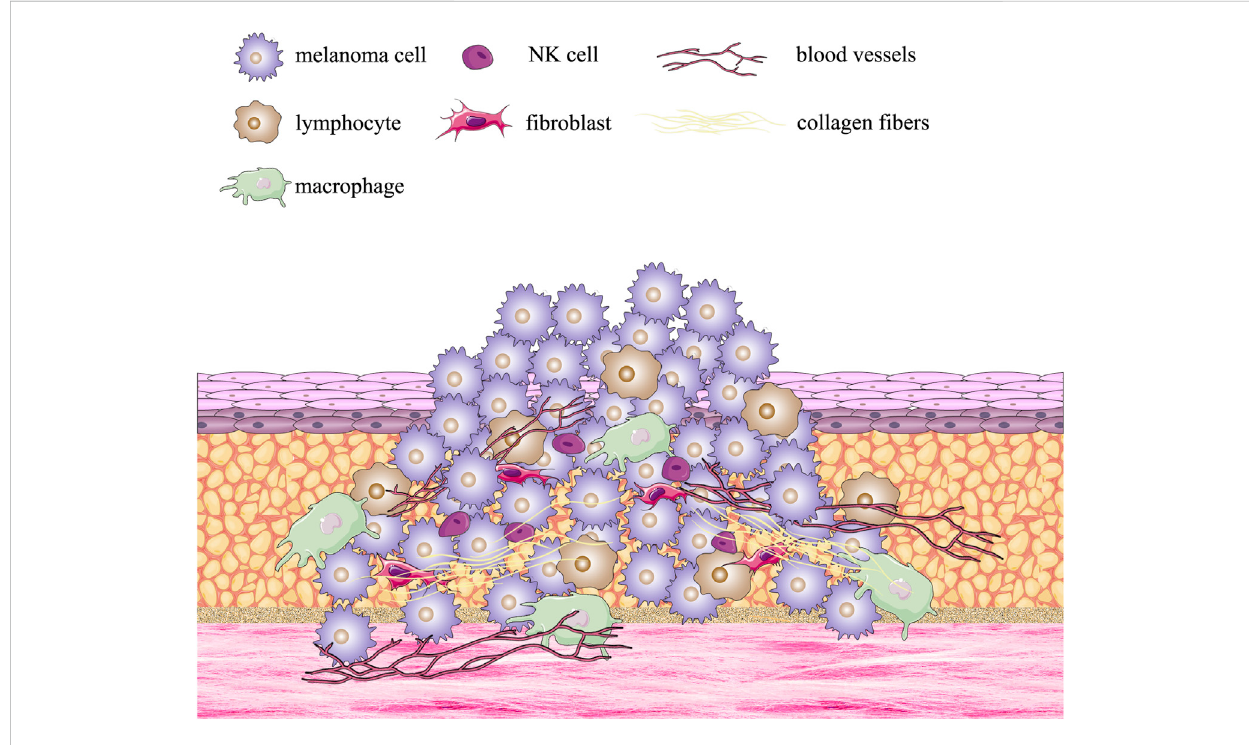
FIGURE 1 Formation of the multiple melanoma tumor